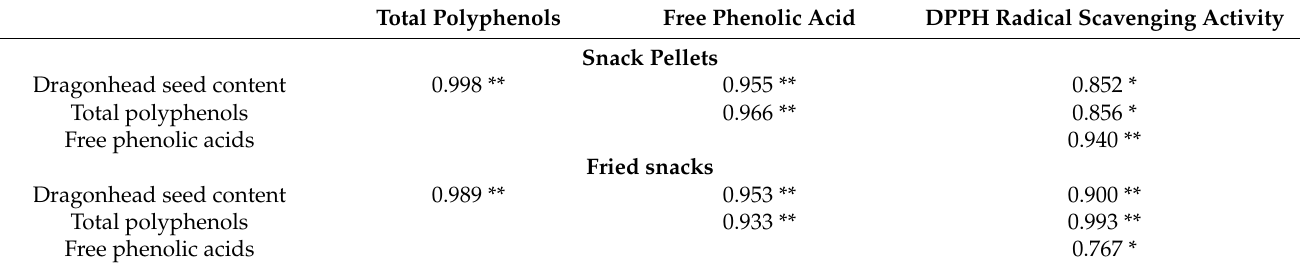
Table 4. Pearson’s correlation coefficients for snacks supplemented with dragonhead seeds. Total Polyphenols Free Phenolic